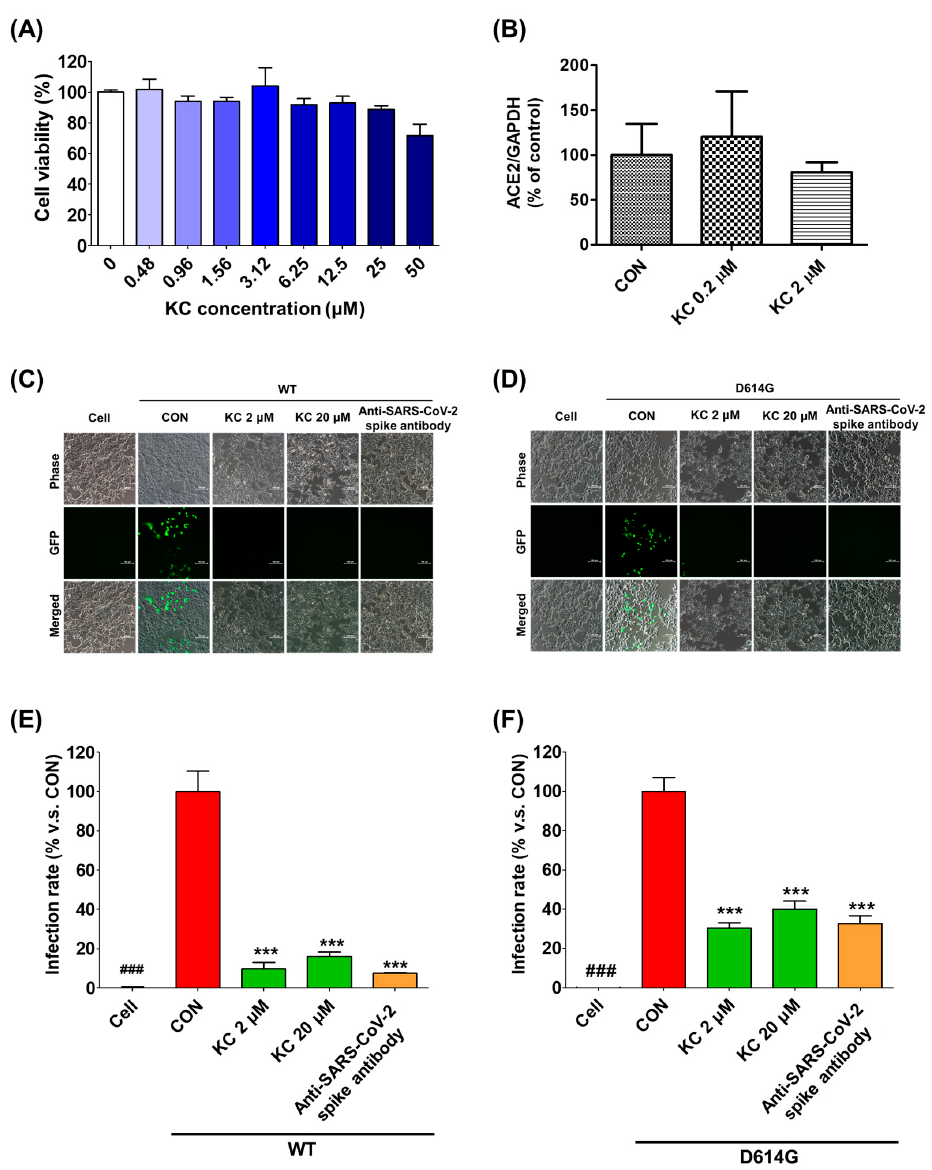
spike S1 RBD and the ACE2 receptor. ACE2/TMPRSS2-overexpressing HEK293T cells were incubated for 24 h with different concentrations of KC (0–50 µM) to determine the noncytotoxic concentration of KC, which was defined as less than 25 µM (Figure 4A). In addition, KC treatment had little effect on the ACE2 expression level in HEK293T cells of KC, which was defined as less than 25 µ M (Figure 4A). In addition, KC treatment had (Figure 4B). little effect on the ACE2 expression level in HEK293T cells (Figure 4B).